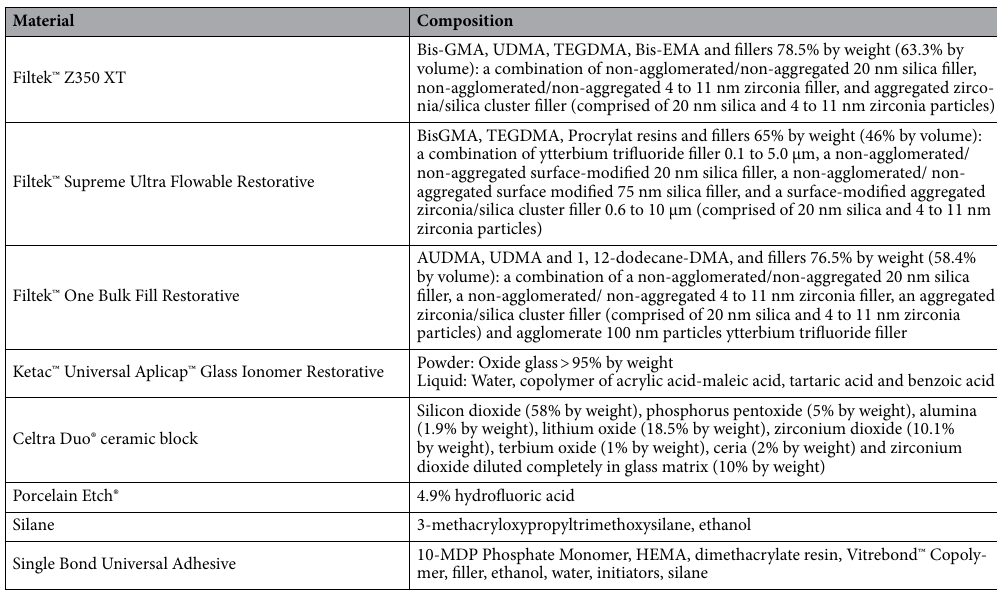
Table 2. Components of the materials used in this